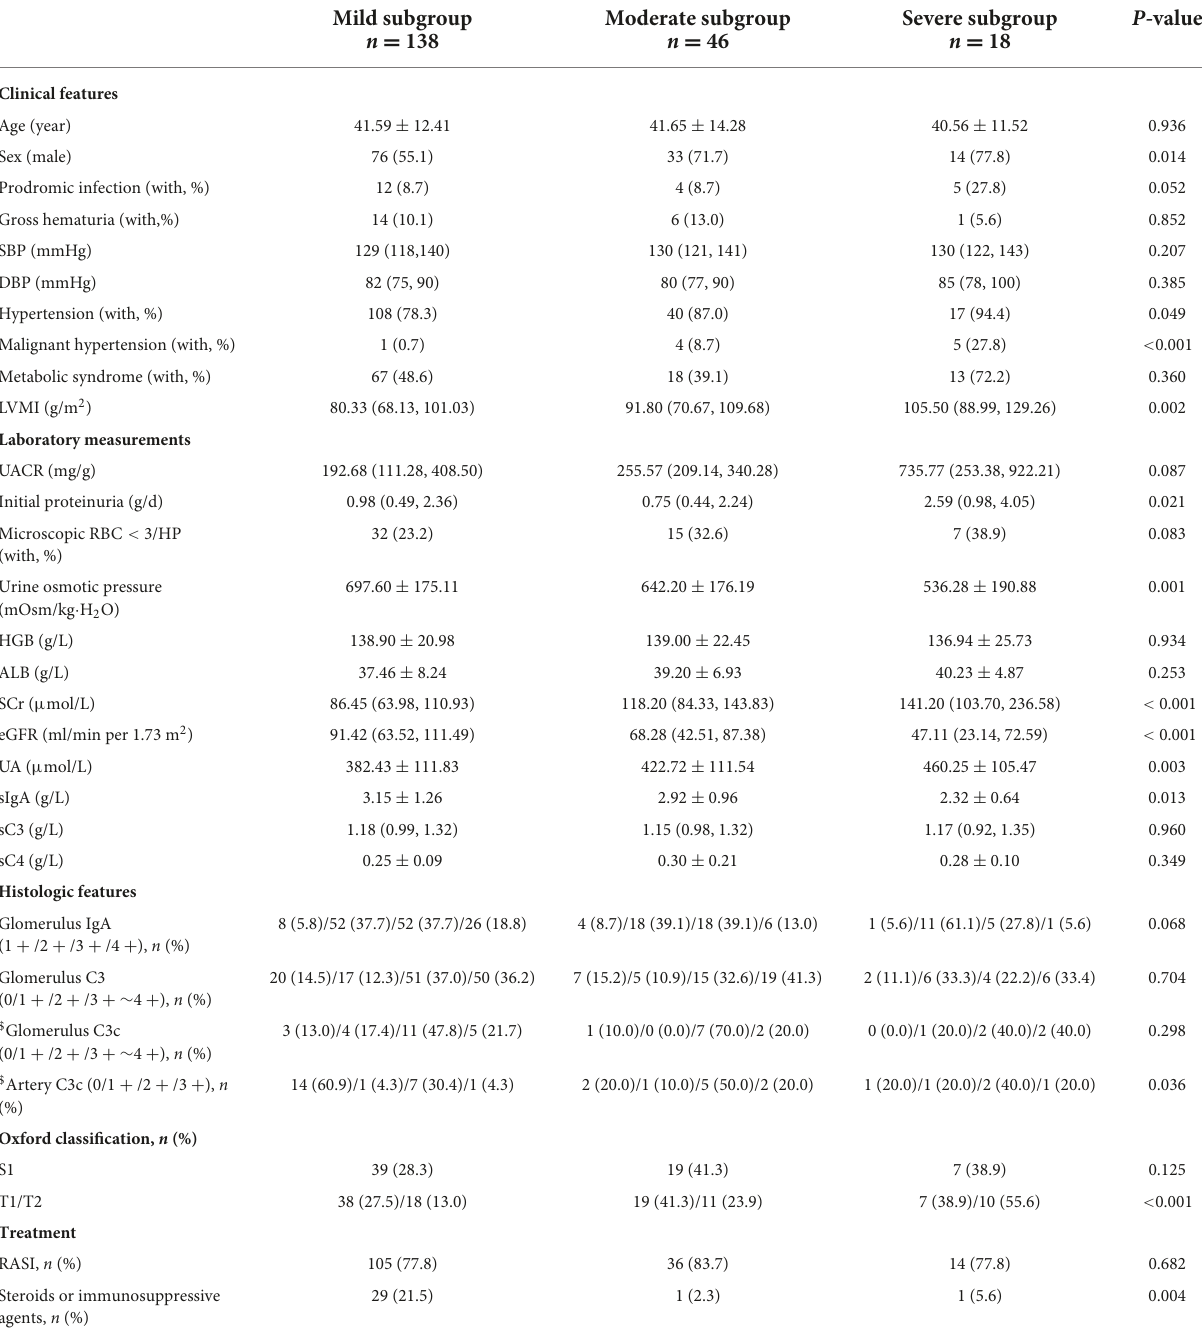
TABLE 2 Demographic, clinical, and histological characteristics of the subgroup of the arteriolar lesions group with IgAN based on the severity of arterial lesions. ( n = 202).